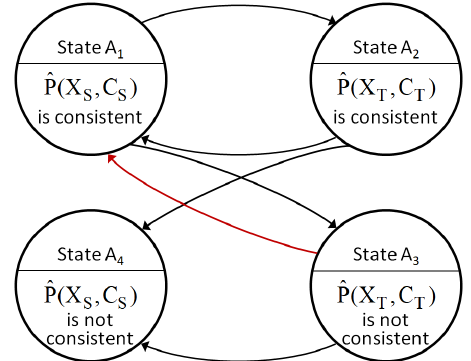
Figure 1: Diagram of circular validation with all possible tran- sitions (adapted from Bruzzone and Marconcini (2010)). The transition from A 3 to A 1 (red arrow) is prohibited according to Bruzzone and Marconcini (2010), thus P ( A 1 | A 3 ) ! = 0